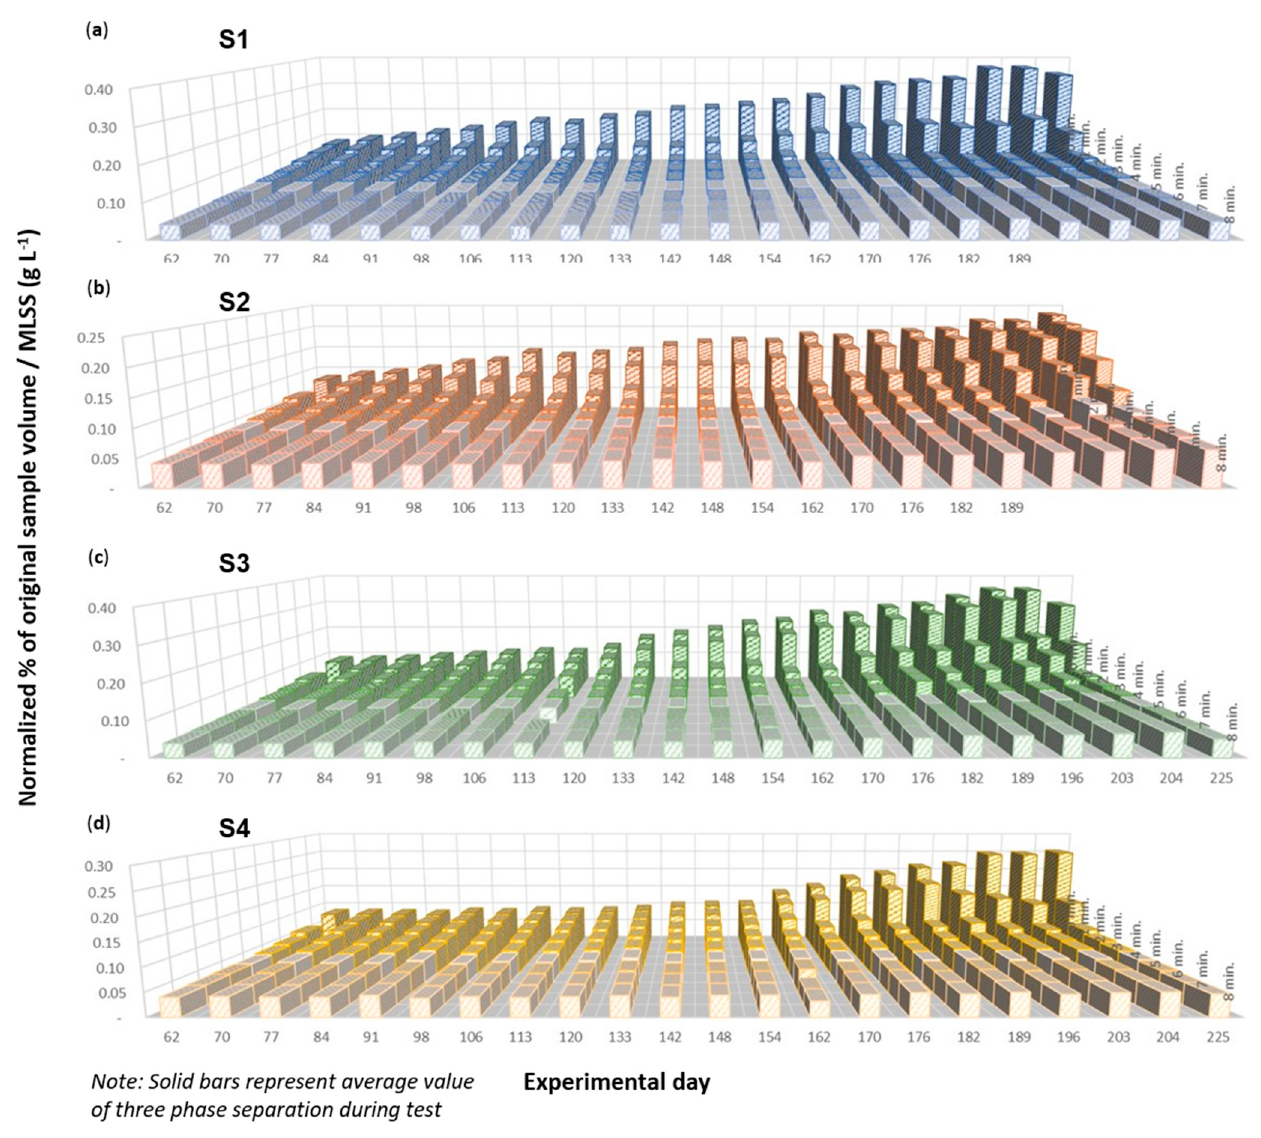
Figure A2. FIC test sludge volumes results normalised to MLSS content in ( a ) S1, ( b ) S2, ( c ) S2 and ( d ) S4. Table A1. Experimental results; SRT effect on: membrane flux, OLR, HRT, feed COD, effluent COD and COD removal rates.